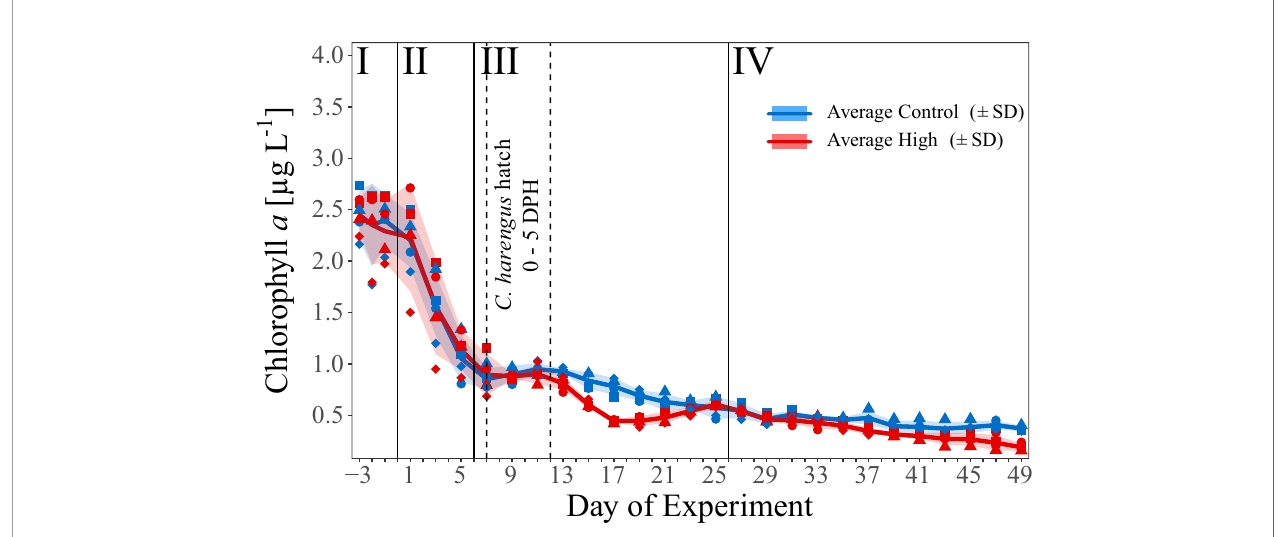
FIGURE 2 | Temporal development of average chl a concentration [μg C L -1 ] over the course of the experiment. Blue and red line indicate the respective average concentration in the control and high p CO 2 treatment. The shaded areas represent the standard deviations (SD). Blue symbols represent concentrations in the control p CO 2 mesocosms (M1, M2, M4, and M7), red symbols in the high p CO 2 mesocosms (M3, M5, M6, and M8), assigned as presented in Figure 1C . Dashed vertical lines mark the start and peak of herring larvae ( C. harengus ) hatch as Days Post Hatch (DPH). I – IV indicate the different phases of the experiment separated by vertical lines (for details on the phases see Spisla et al.,